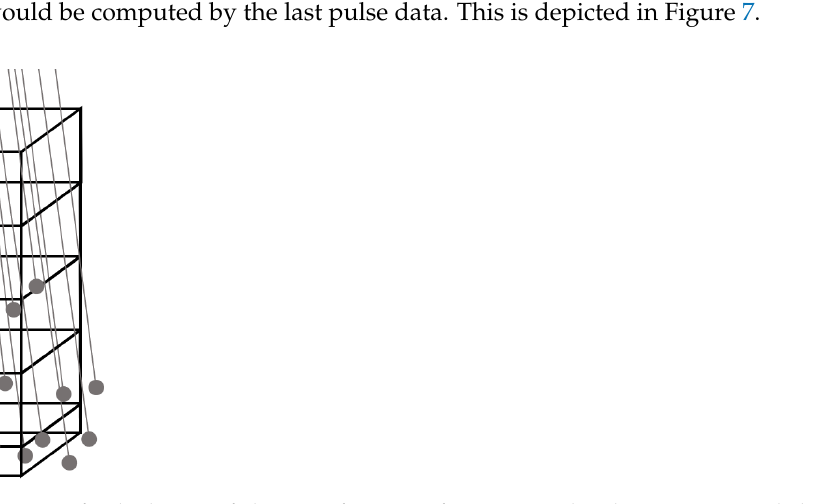
Figure 7. Schematic of calculation of the area fraction of vegetation by the test rays and the reflexion points.